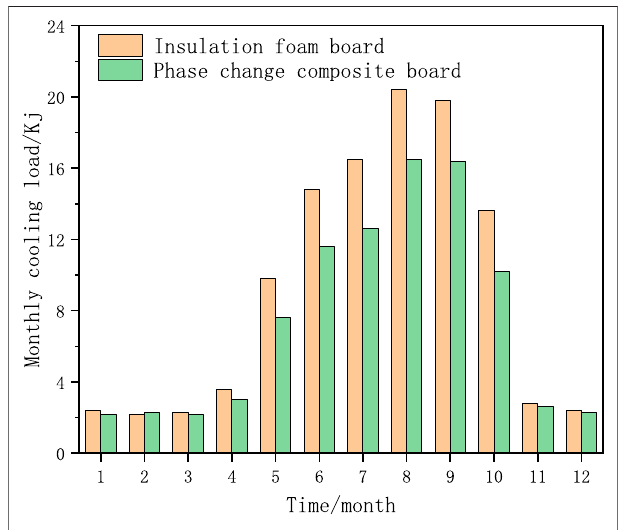
FIGURE 19 | Simulation results of annual cooling load in Shanghai.